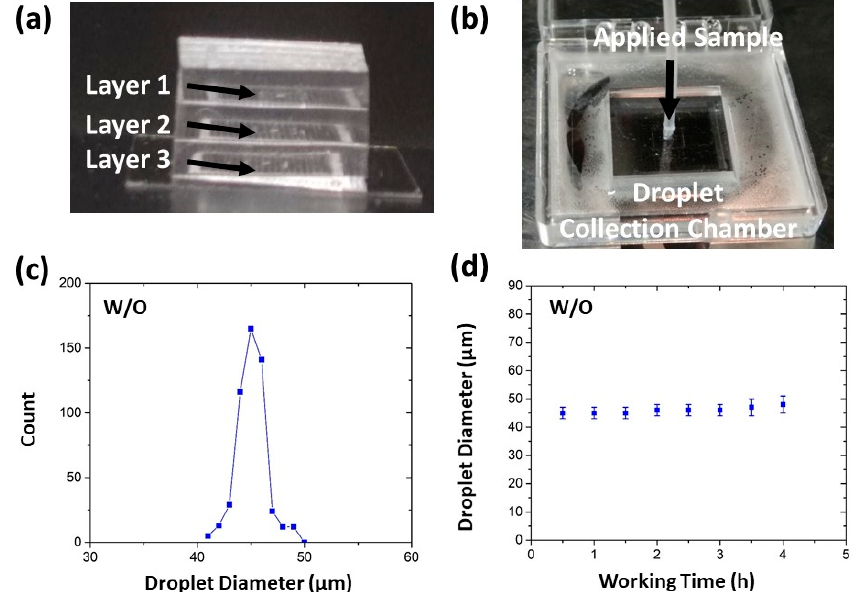
Figure 4. ( a ) A photograph showing a multi-layer device by stacking three layers of the HIDS generators (each layer is composed of 400 HIDS generators). ( b ) A photograph showing the operation of the multi-layer device in a collection container using only one pressure source for the dispersed phase. ( c ) The size distribution of W/O droplets of a multilayer device. ( d ) The droplet diameter remains unchanged over a duration of 4 h operation.